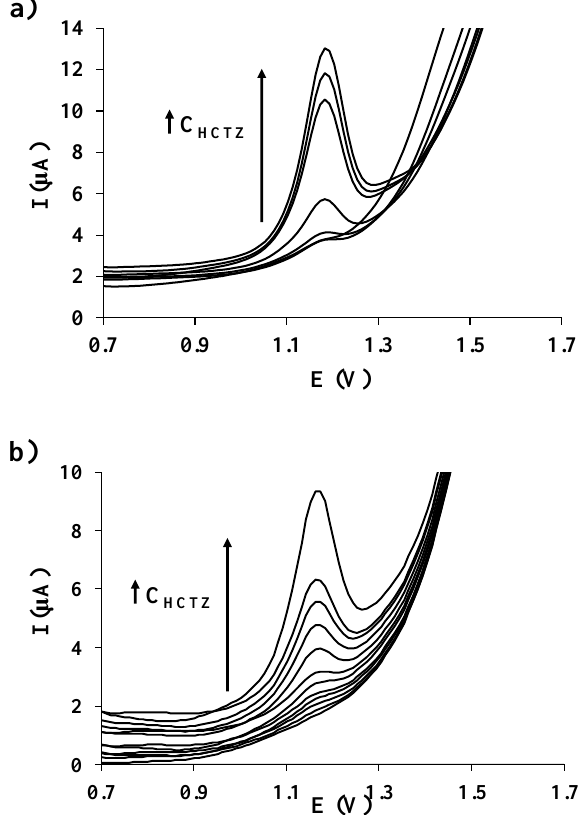
Figure 4. DP voltammetric measurements of increasing concentrations of HCTZ in HCl 0.01 mol L −1 recorded on ( a ) SPCE/PGA (from 10.0 to 300.0 µmol L −1 ); and ( b ) SPCE/EGA (from 1.0 to 200.0 µmol L −1 ).